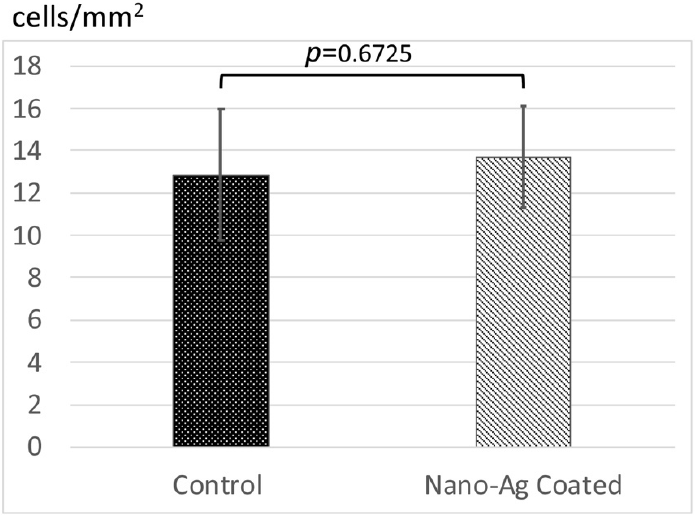
Figure 3. Fluorescent images after 24 hours incubation: ( a ) control; ( b ) nano-Ag coating. The morphology of actin filaments (red) and nuclei (blue) indicate no difference between control and nano-Ag coating.